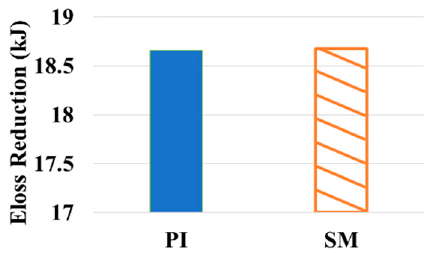
Figure 14. The energy loss reduction of the DC microgrid with PI and SM control.